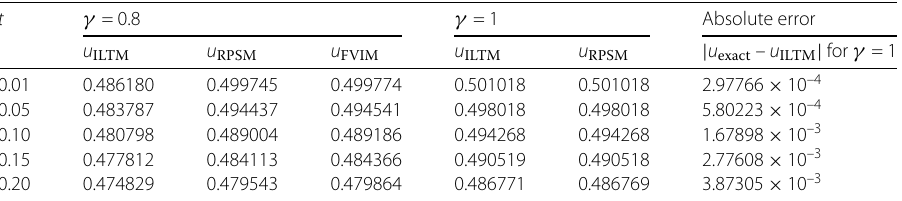
Table 1 Numerical comparison between approximate solutions u ILTM , u RPSM , u FVIM and exact solution of (23) for x = 0.01, θ = 0.8